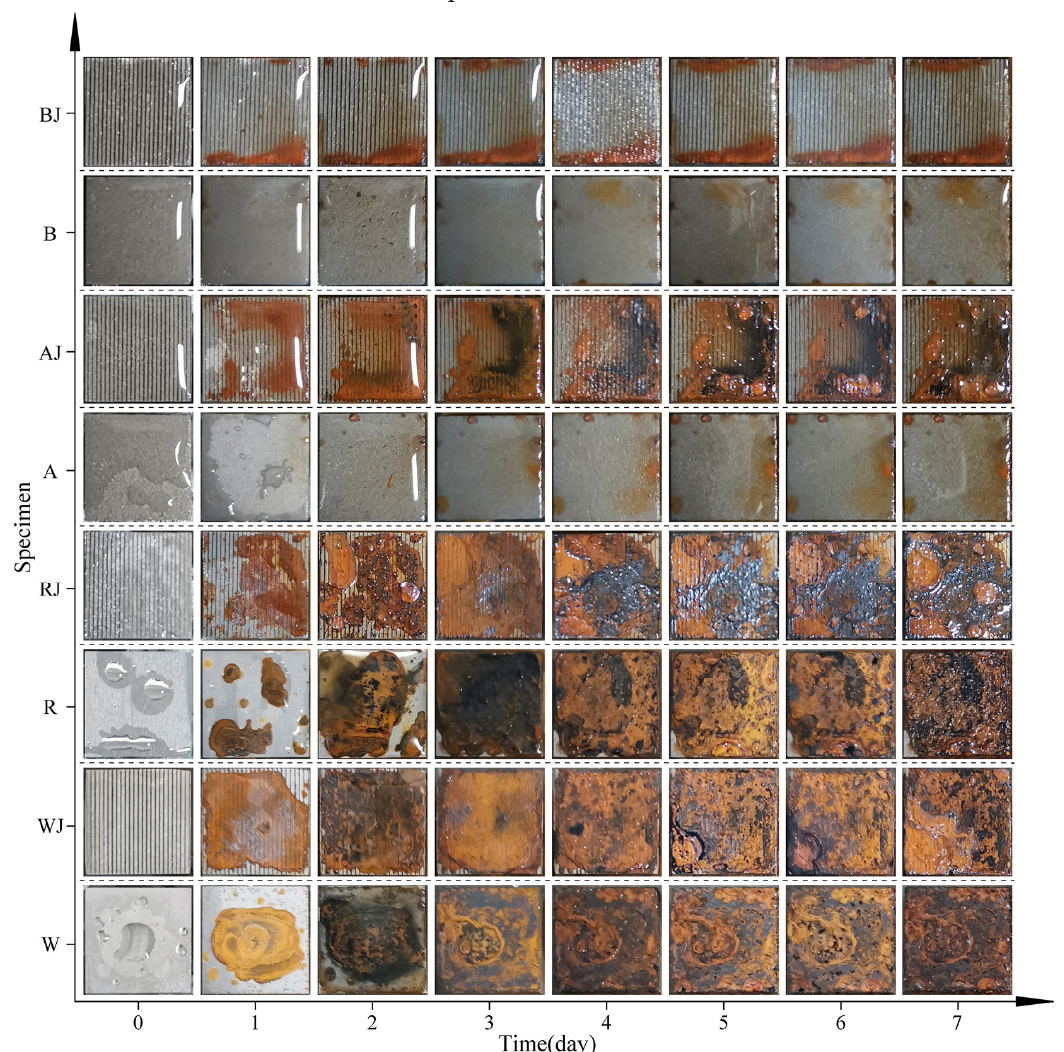
Figure 10. Comparisons of uncorroded and corroded specimens.